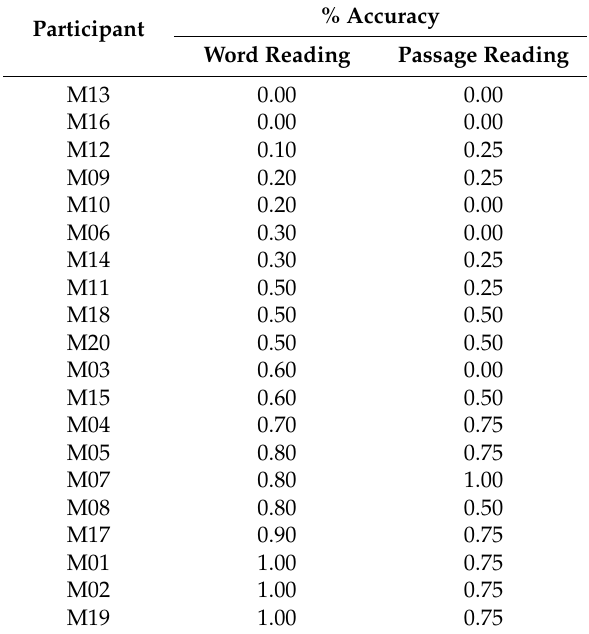
Table 4. Percent accuracy realization of the L2 English flap in the word-reading task and the passage-reading task. % Accuracy Participant Word Reading Passage Reading M13